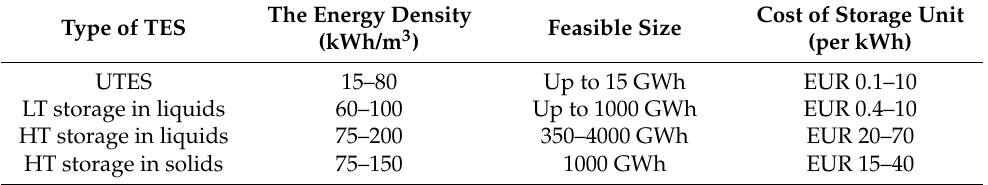
Table 3. Characteristics of low/high-temperature sensible energy storage technologies